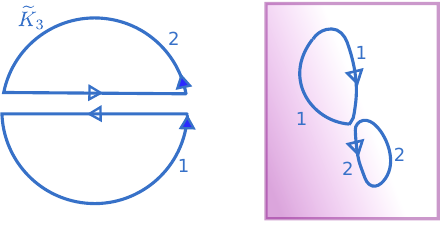
Figure 23 . A lift e K 3 of K involving an exchange. Left: standard projection. Right: leaf space projection. Referring to the standard projection, the top half of K is lifted to sheet 2 of f M while the bottom half is lifted to sheet 1. The 1-orientation of the leaf space is the standard orientation of the plane, while the 2-orientation is the